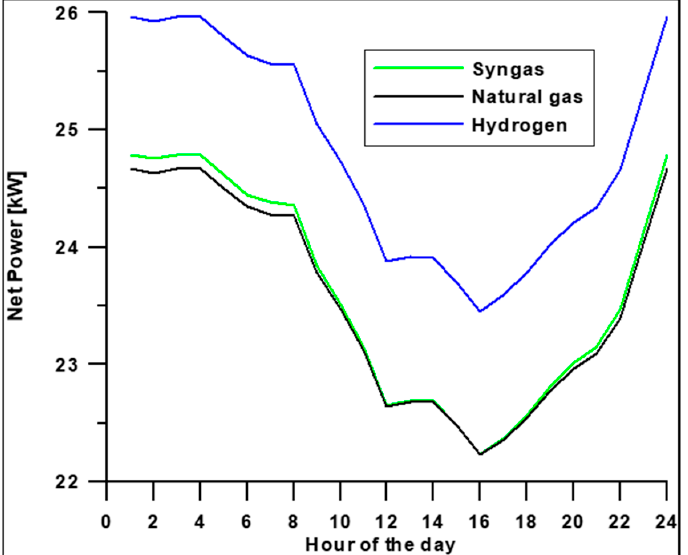
Figure 8. Net power calculated for the three fuels.